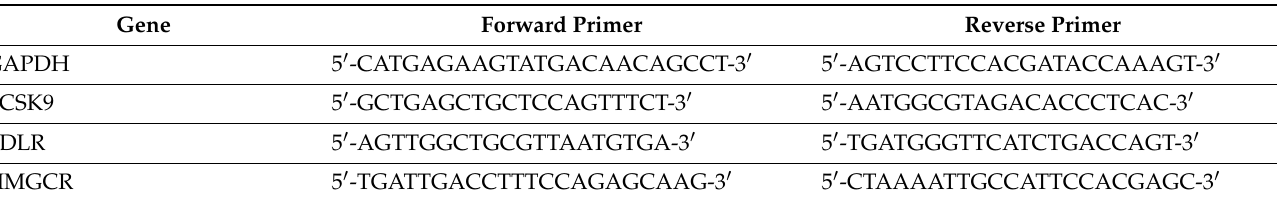
Table 2. List of real-time PCR primer